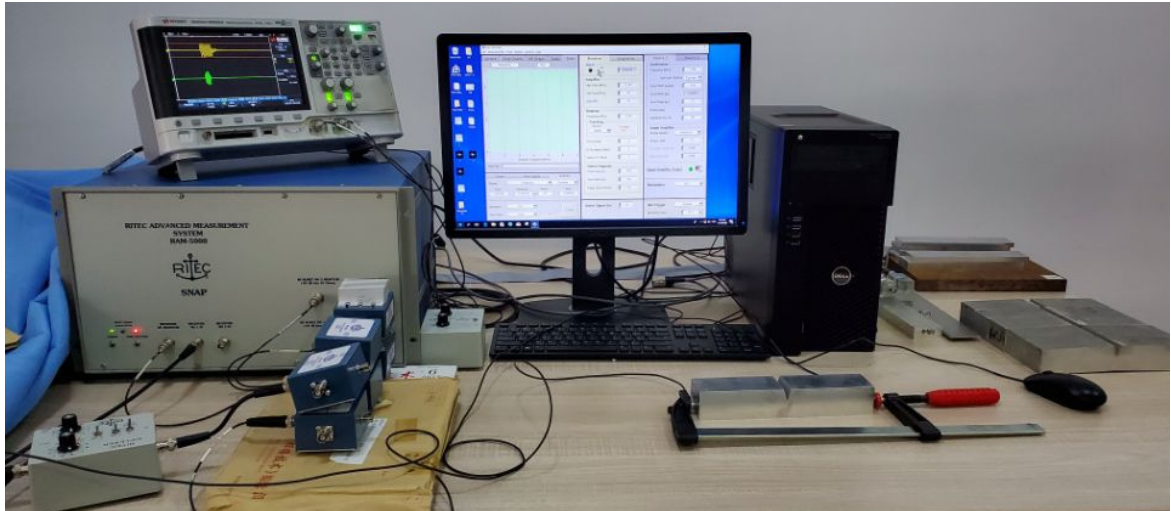
Figure 4. Experimental platform.